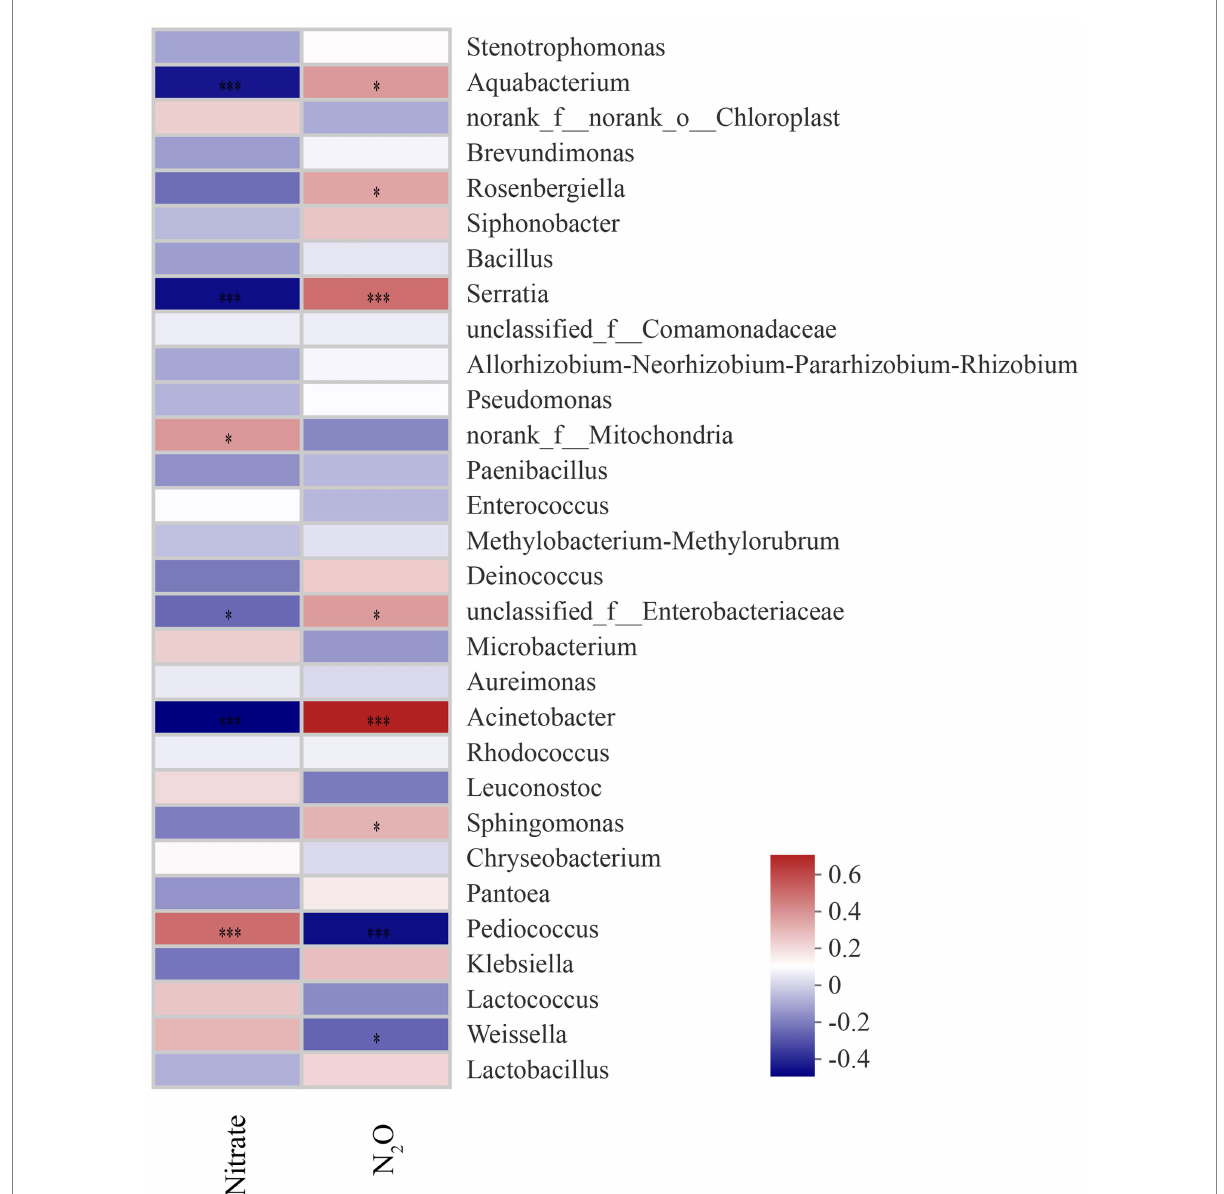
FIGURE 6 Correlation of bacterial communities with nitrate and N 2 O content ( p -values are shown as *0.01 < p ≤ 0.05, *** p ≤